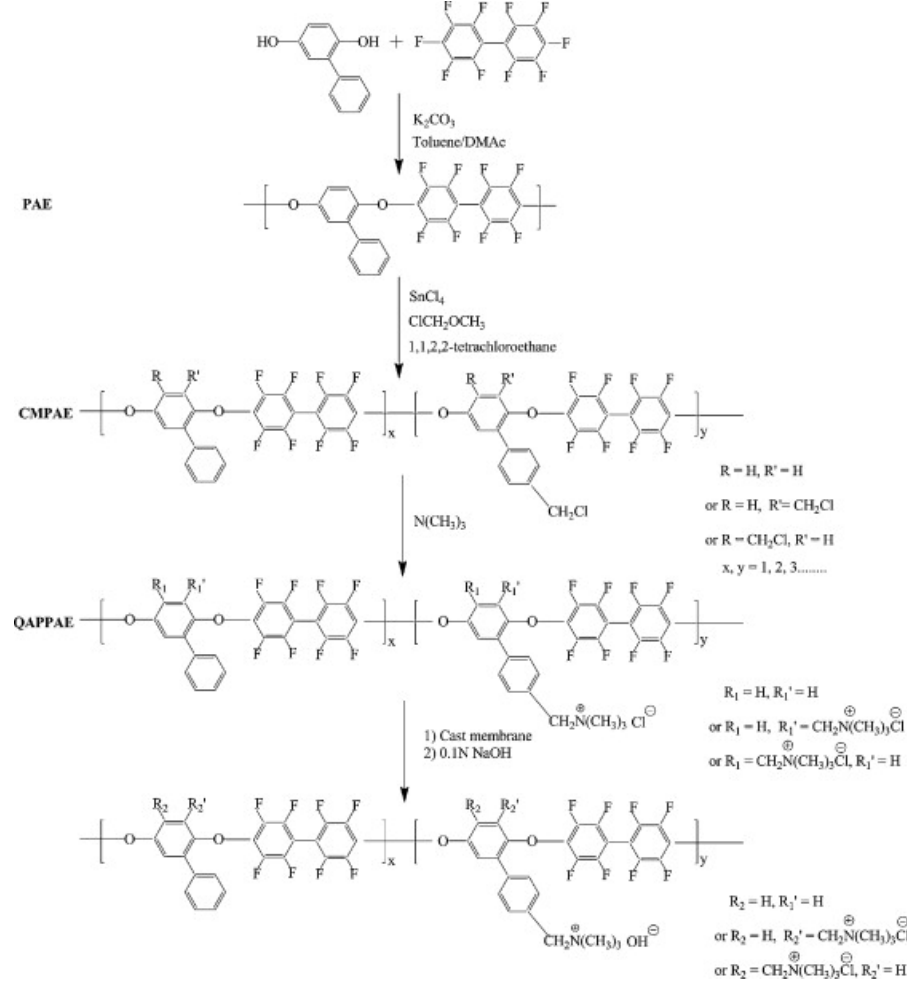
Figure 3. Synthetic route for partially fluorinated copoly(arylene ether) ionomers with